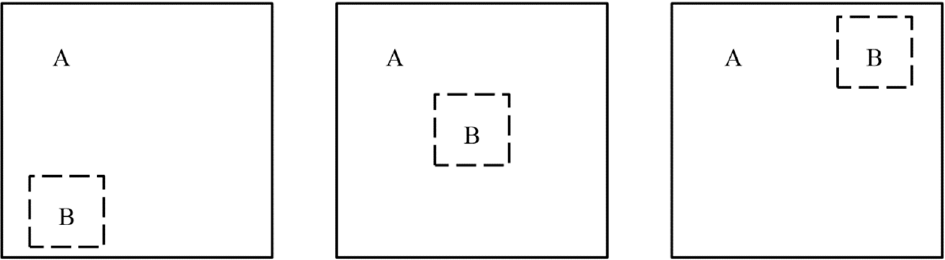
Figure 7. Schematic diagram of the relationship between the predicted frame and the real frame position.